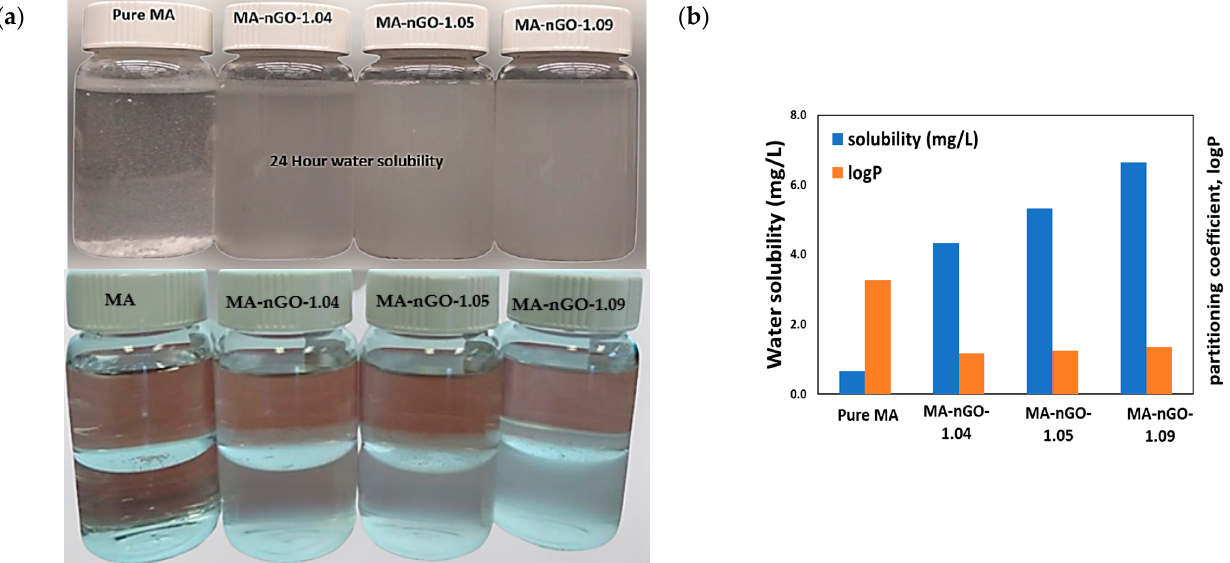
Figure 4. ( a ) Photograph of MA-nGO composites 24-hour solubility in water (upper) and octanol-water partitioning (lower). ( b ) Water solubility and octanol-water partitioning coefficient (logP) of MA-nGO composites.